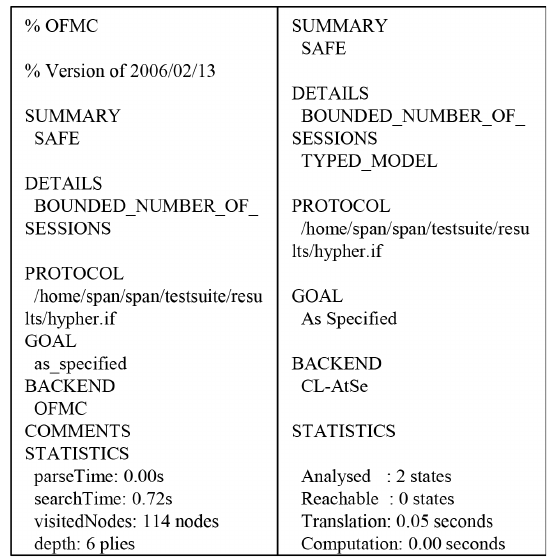
Figure 13. AVISPA simulation